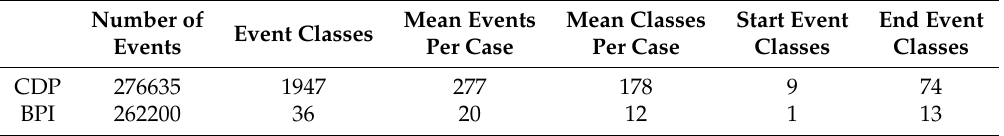
Table 8. Comparison of CDP and BPI logs.